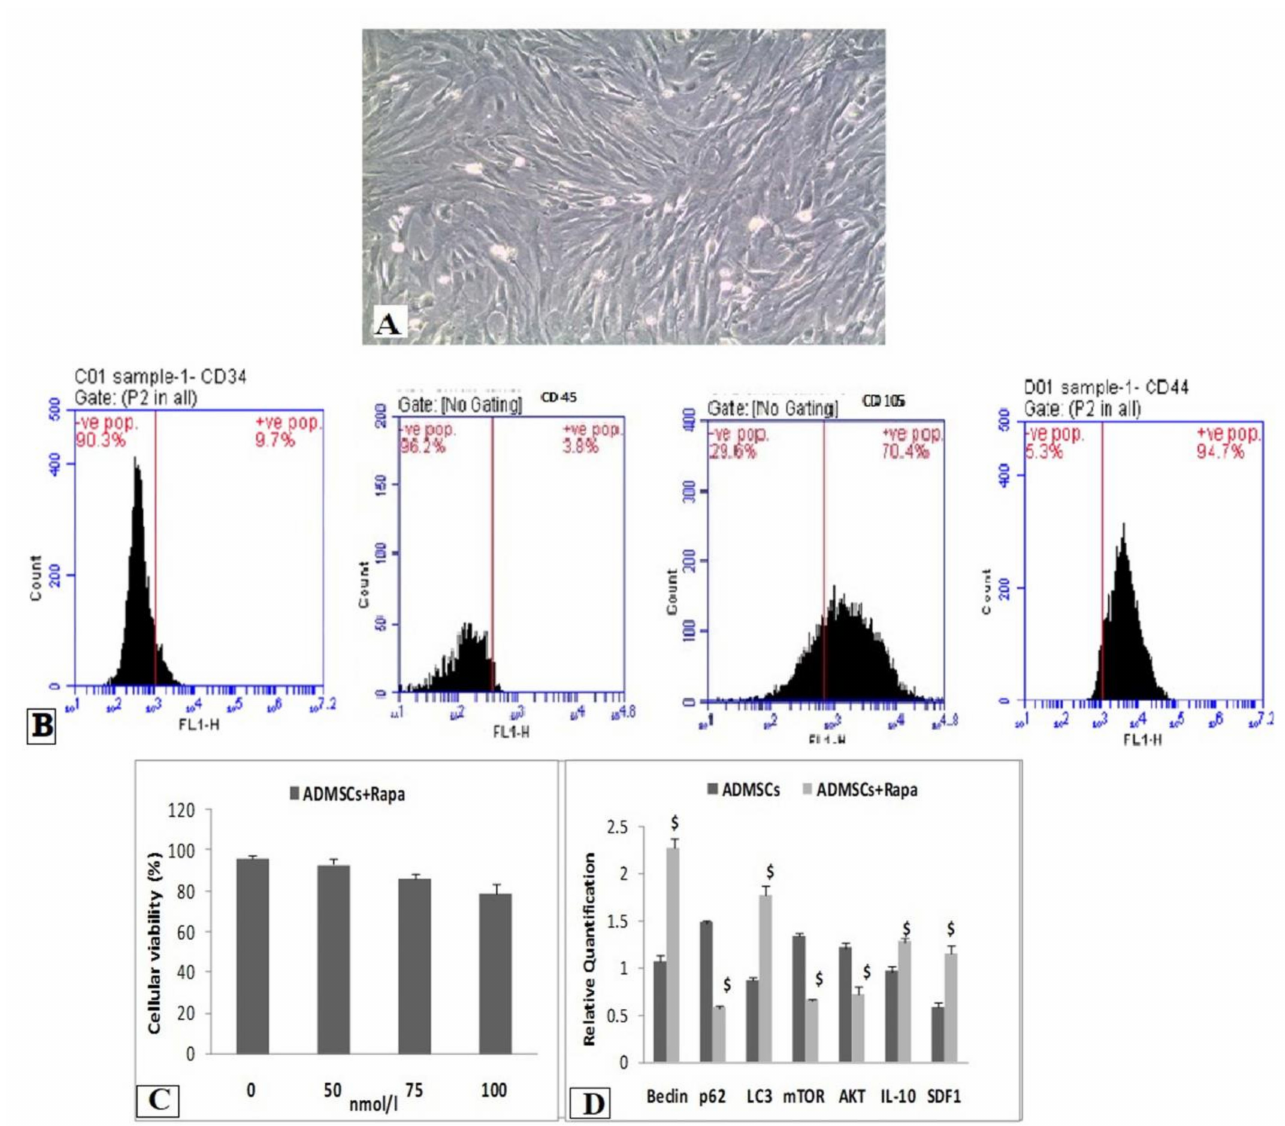
Figure 1. In vitro studies on Rapa-ADMSCs. ( A ) ADMSCs at passage 3 (400 × ), ( B ) flowcytometric analyses for the markers of ADMSCs (negative for CD34 and CD45 and positive for CD105 and CD44), ( C ) the effect of Rapa treatment on the viability of ADMSCs for 2 h in culture and ( D ) the expression rate of autophages, migration and pro-inflammatory genes for Rapa treated and untreated cells. $ Significant vs. ADMSC group ( p <